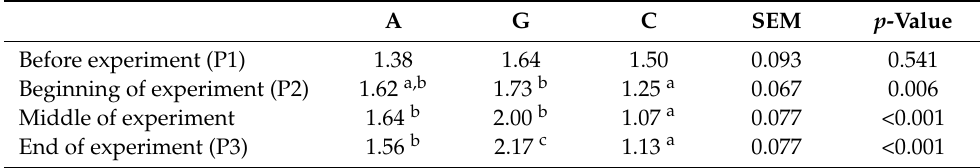
Table 1. Average scores for the appearance of sphincters.